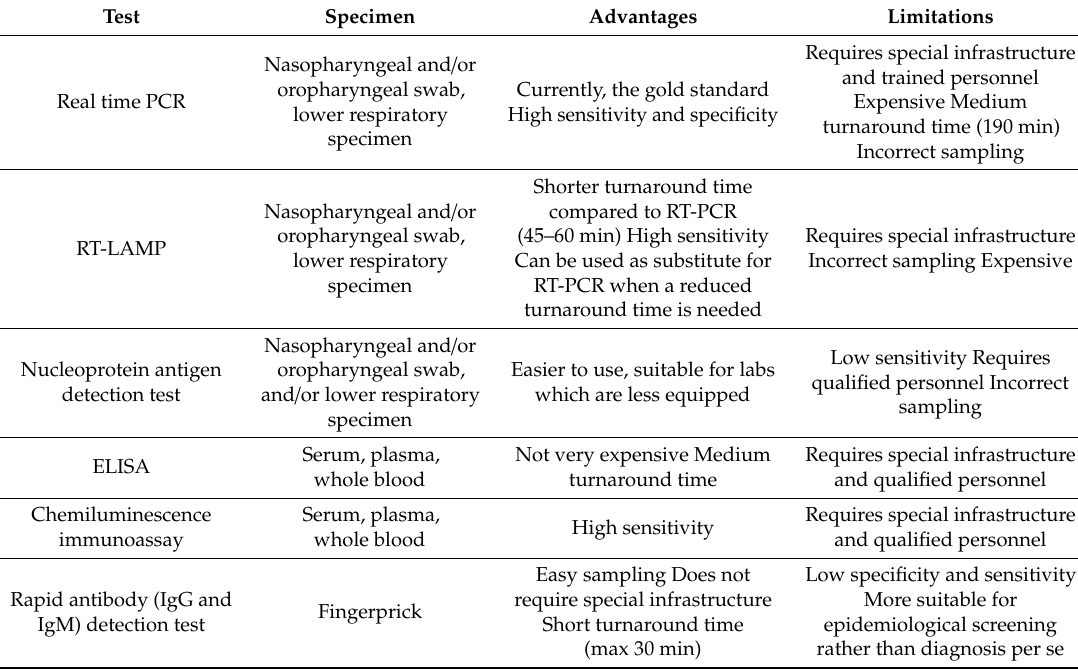
Table 1. Diagnostic tools for SARS-CoV 2 infection (adapted from Russo et